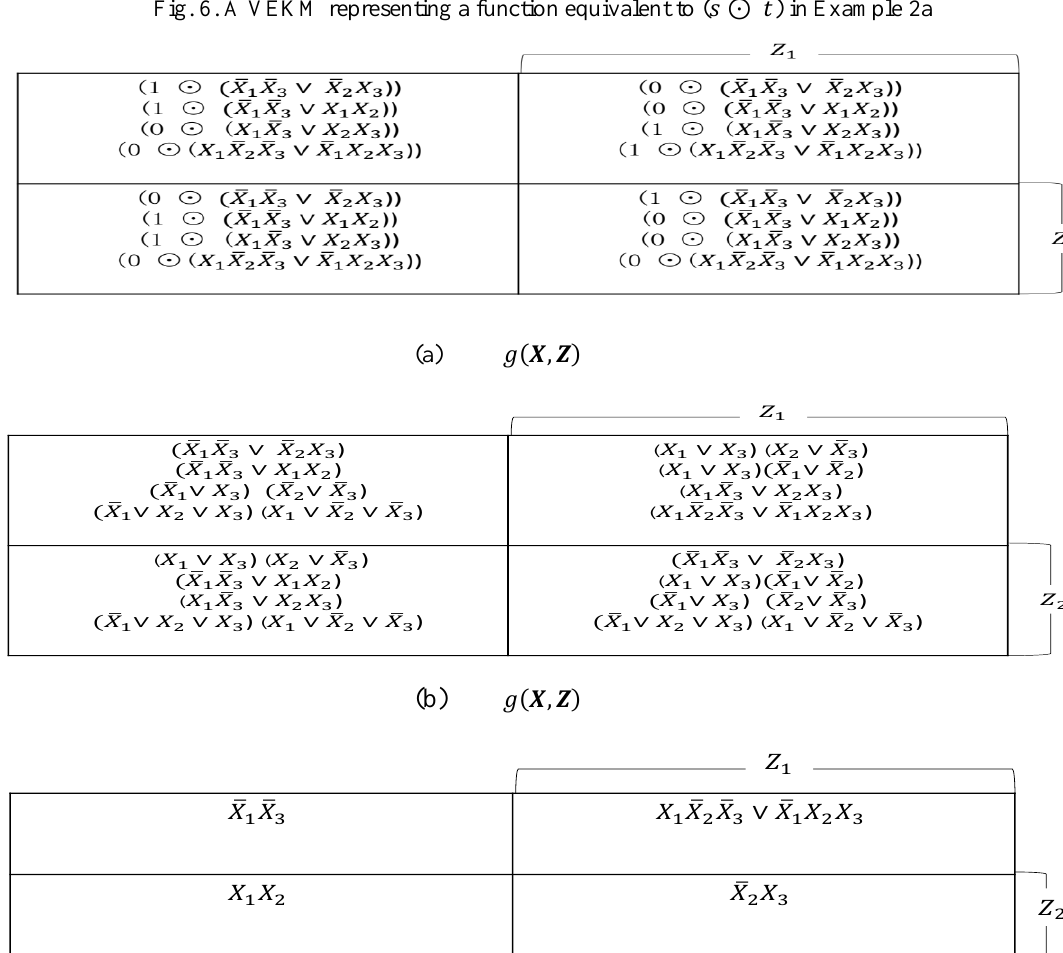
Fig. 6. A VEKM representing a function equivalent to ( 𝑠 ⊙ 𝑡 ) in Example